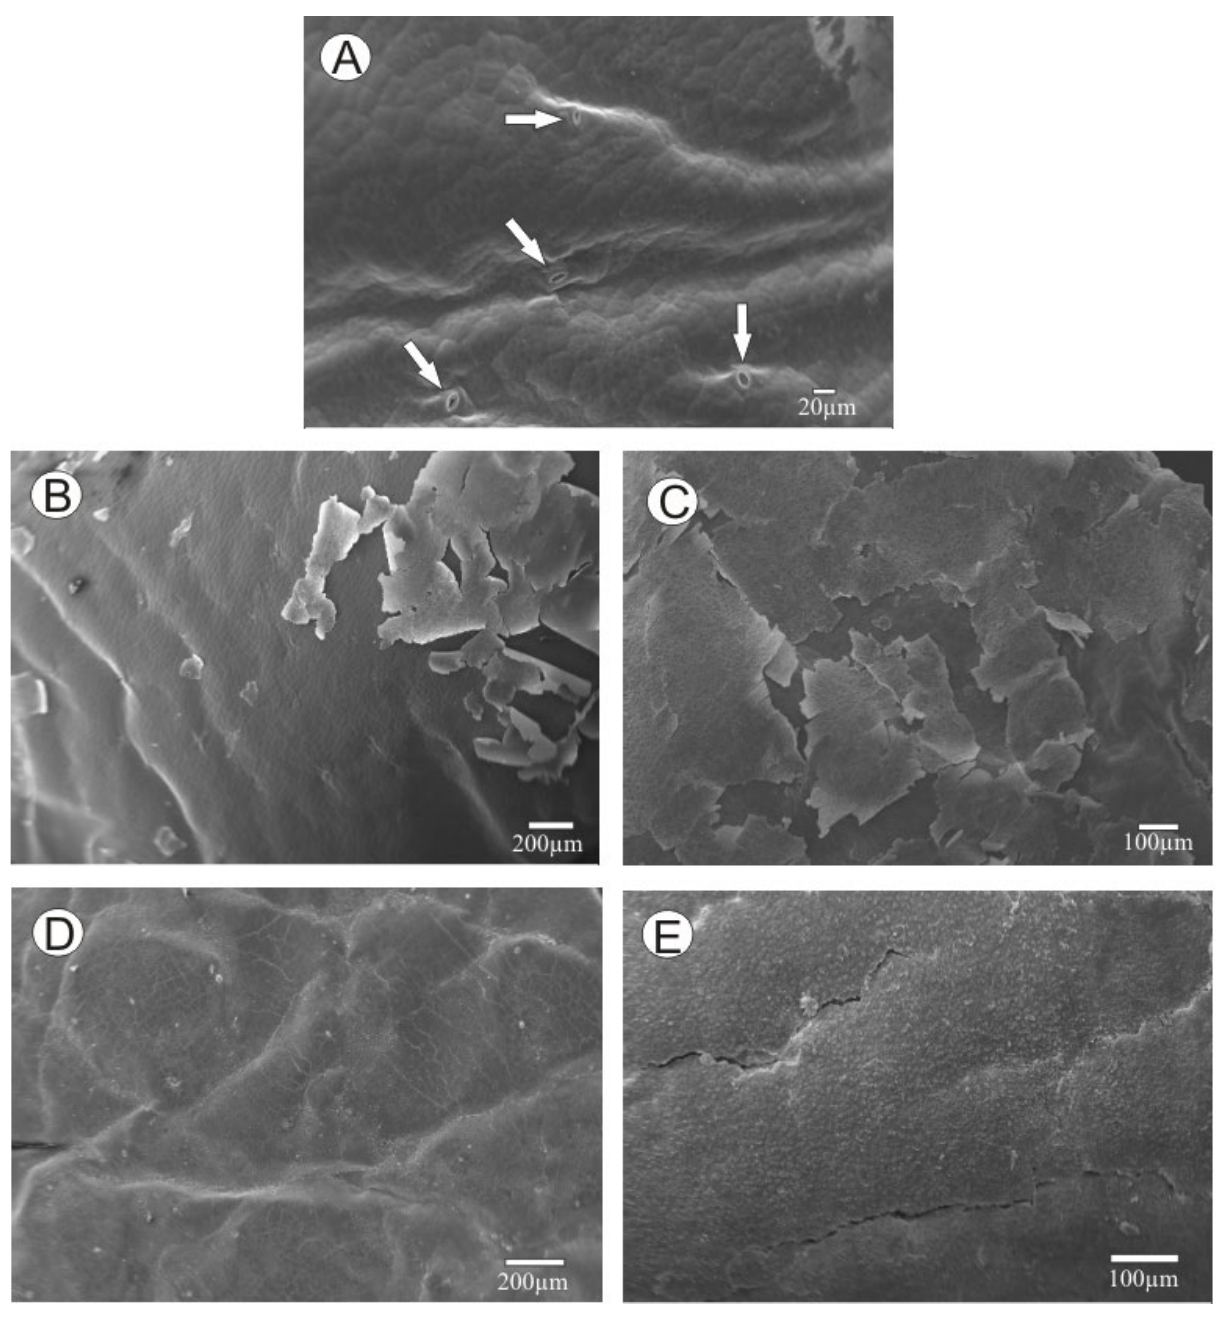
Figure 5. Scanning electron micrographs of papaya epicarps: A) non-coated fruit surface with visible stomata (arrows); B) fruit surface coated with cassava starch gel at 1% concentration; C) coated with 2% concentration; D) coated with 3% con- centration, and E) coated with 4% starch gel